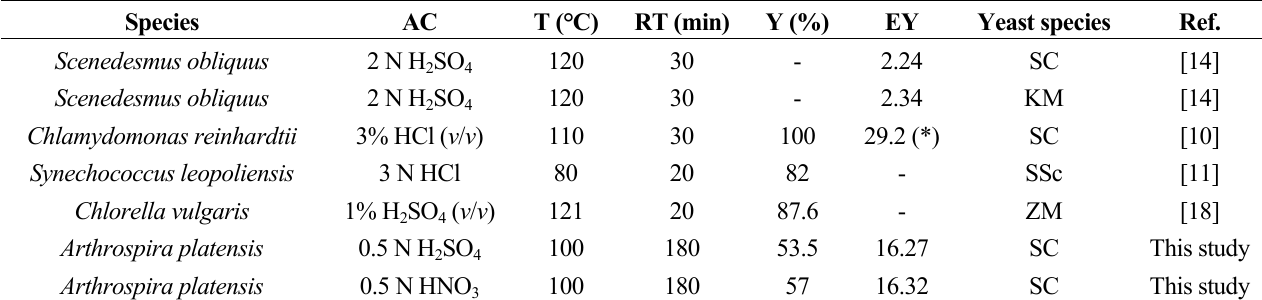
Table 3. Comparison of ethanol yield of several selected biomass (AC: acid concentration, T: temperature, RT: reaction time, Y: yield from theoretical values, EY: bioethanol yield (%, g /g ), SC: Saccharomyces cerevisiae , SSc : Saccharomyces sake , KM: Kluyveromyces EtOH Biomass marxianus , ZM: Zymomonas mobilis , (*): theoretical values, given by the authors). Species AC T (°C) RT (min) Y (%) EY Yeast species Ref. Scenedesmus obliquus 2 N H SO 120 30 - 2.24 SC [14] 2 4 Scenedesmus obliquus 2 N H SO 120 30 - 2.34 KM [14] 2 4 Chlamydomonas reinhardtii 3% HCl ( v / v ) 110 30 100 29.2 (*) SC [10] Synechococcus leopoliensis 3 N HCl 80 20 82 - SSc [11] Chlorella vulgaris 1% H SO ( v / v ) 121 20 87.6 - ZM [18] 2 4 Arthrospira platensis 0.5 N H SO 100 180 53.5 16.27 SC This study 2 4 Arthrospira platensis 0.5 N HNO 100 180 57 3